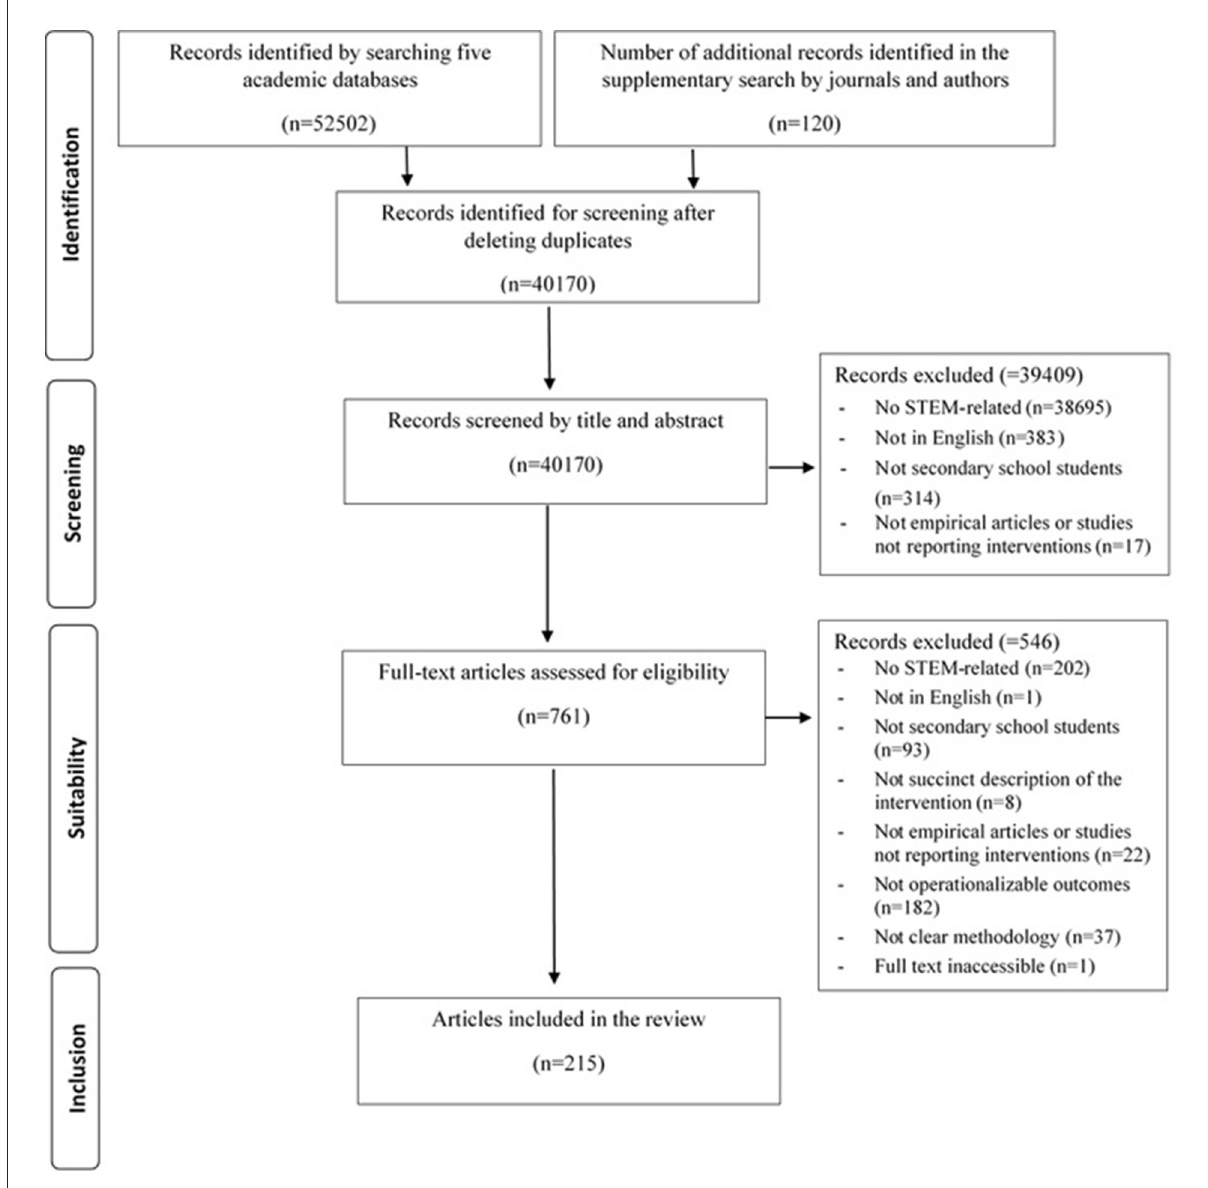
FIGURE1 Flow-chart diagram illustrating inclusion and exclusion of articles during search process.